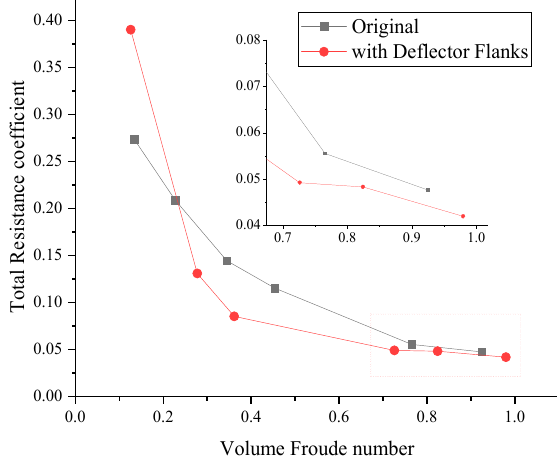
Figure 21. Diagram of test